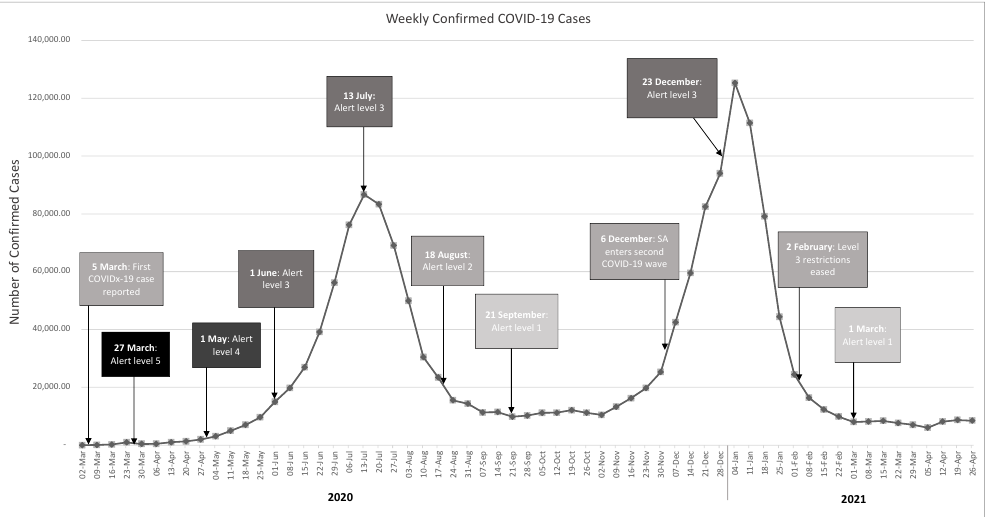
Figure 1. A line graph illustrating the annual number of HIV tests conducted in each province of South Africa, from 2018 to the end of 2020. Data was collected from the National Department of Health website, and represents HIV testing trends in the public health sector [17]. Each point represents the number of HIV tests conducted in the province for that specified year. The trend lines show that between 2018 and 2020, HIV testing in every province increased. In contrast, the trend line for 2020–2021 fell much lower than previous years. No significant change in HIV testing was observed for Free State and the North West, while Gauteng experienced the most drastic decline between 2019–2020 and 2020–2021. This graph has been adapted from Pillay et al. [18].